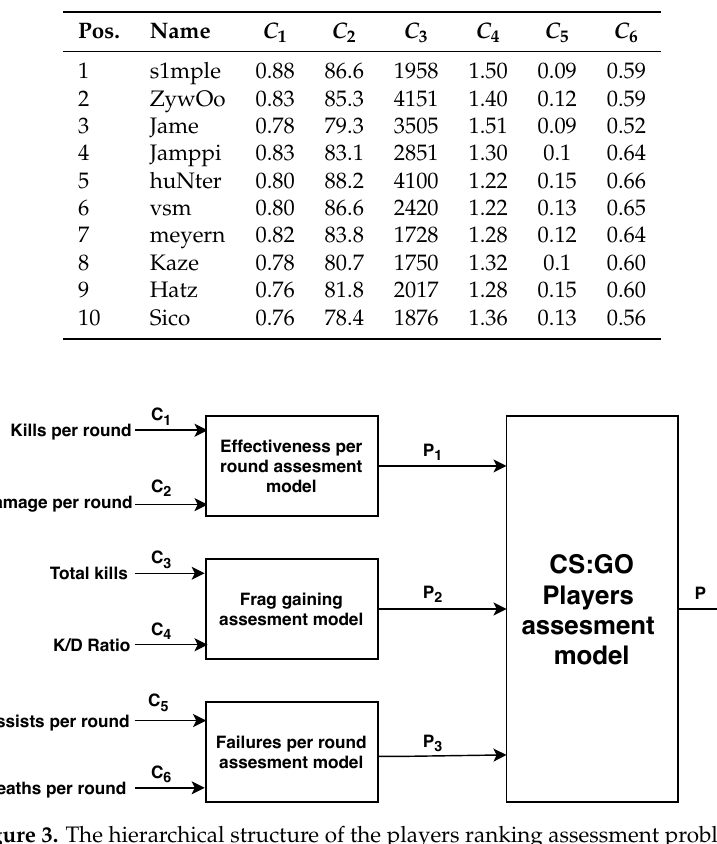
Table 2. The performance table of the alternatives and selected criteria.